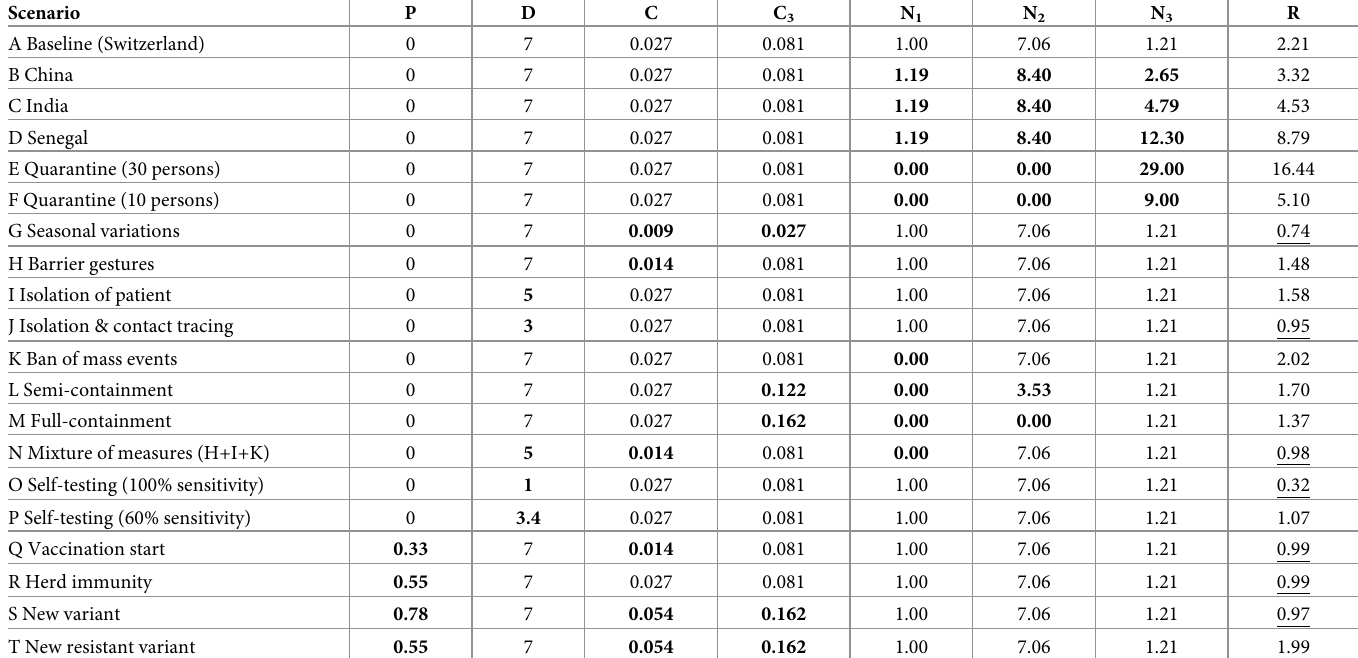
Table 1. Values of the seven parameters of our model defined by Formula 4 according to 20 scenarios to manage the SARS-CoV-2 epidemic, together with the resulting reproduction number R characterizing the spread of the disease.